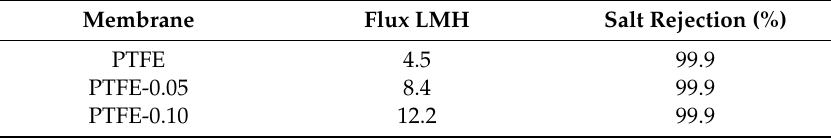
Table 3. Membrane distillation performance–water flux vs. salt